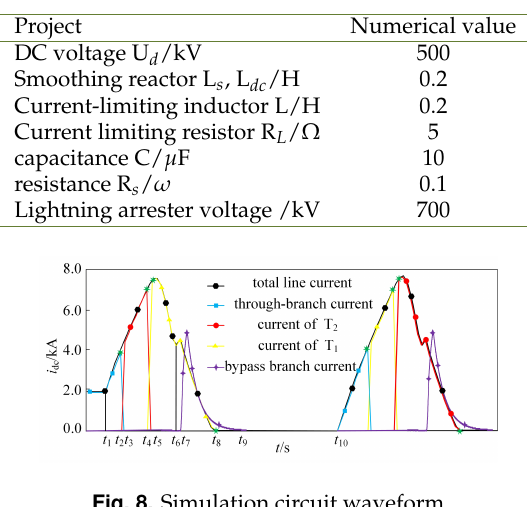
Fig. 7. is a diagram of the change rule of the fault line